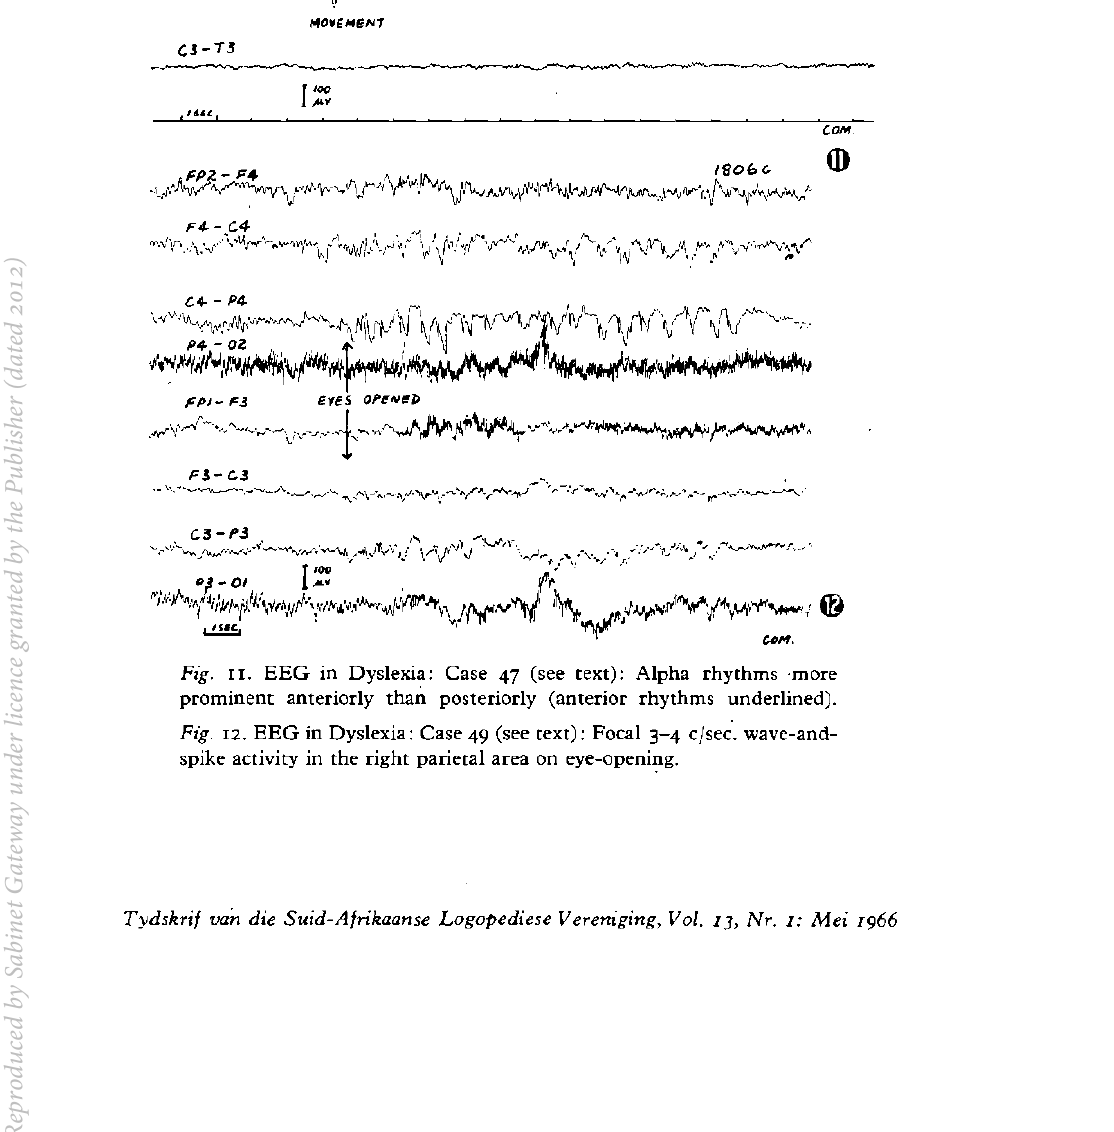
Tydskrif van die Suid-Afrikaanse Logopediese Vereniging, Vol. 13, Nr. 1: Mei